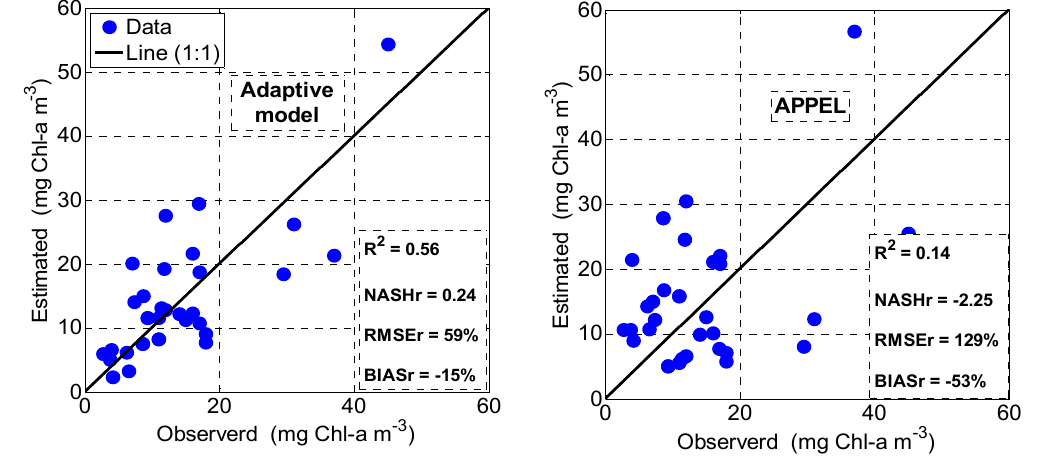
Figure 10. Chlorophyll-a concentration estimated from the four models compared to in situ measurements for the database using only values <50 mg Chl-a m − 3